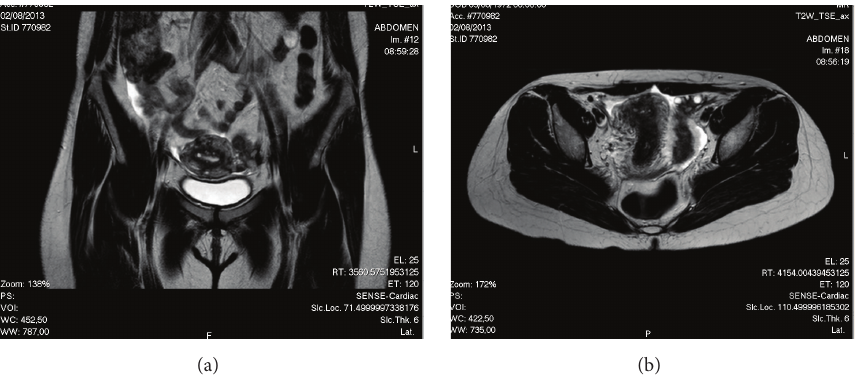
Figure 3: MRI: T2-weighted imaging. (a) Coronal view. (b) Axial view: uterus with multiple small nodules regarded as leiomyomas and with some endometrial glands suggesting adenomyosis.